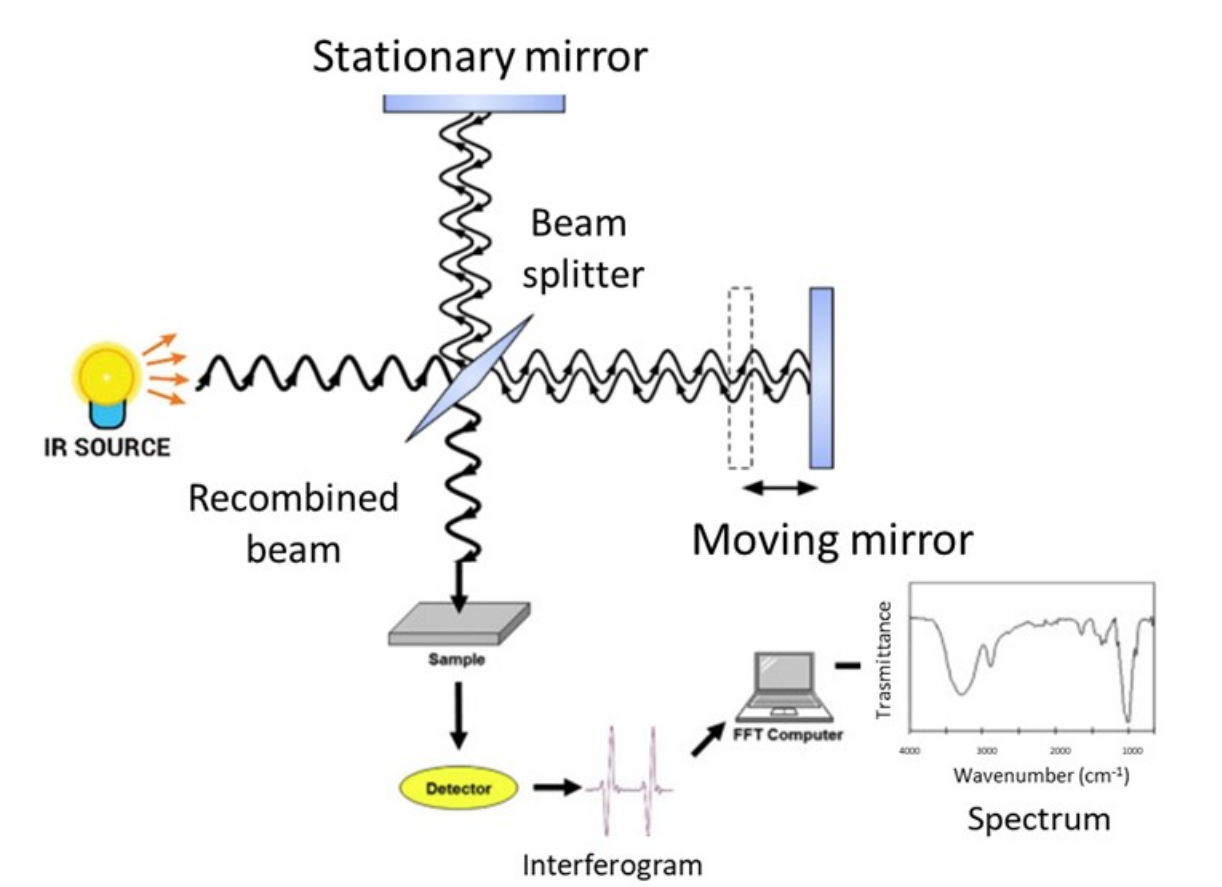
Figure 1. Schematic representation of a FT-IR spectrometer.